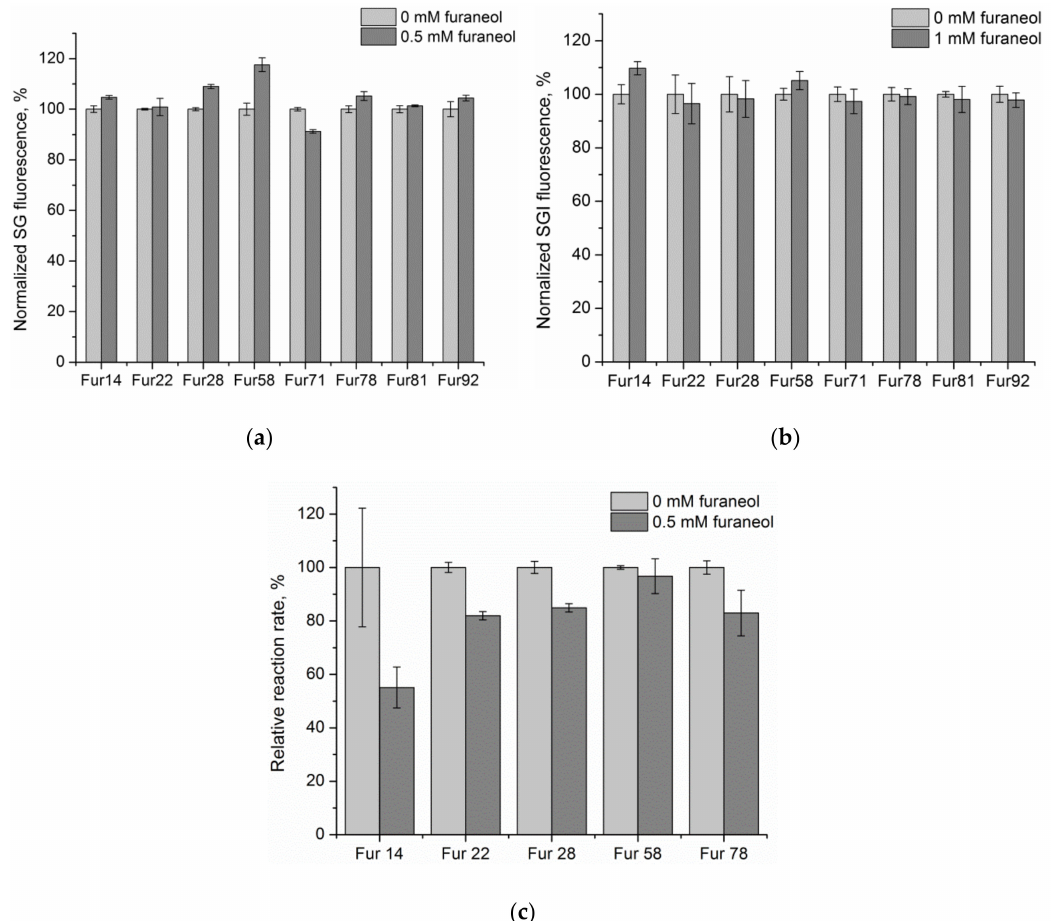
Figure 3. ( a ) Comparison of the ssDNA amount eluted by the buffer (0 mM furaneol, background elution) and by 500 µ M of furaneol. Measurements were performed in duplicates. Background elution for each aptamer was set as 100%. ( b ) Comparison of the SGI fluorescence intercalated with the aptamer candidates, in the absence (0 mM) and in the presence of 1 mM furaneol. Measurements were performed in triplicates. Fluorescence in the absence of furaneol was set as 100%. ( c ) Comparison of the initial reaction rates of the ssDNA degradation by exonuclease I, for each aptamer candidate, in the absence of furaneol and in the presence of 0.5 mM furaneol. Measurements were performed in duplicates. Reaction rate for each aptamer, in the absence of furaneol was set as 100%. Error bars for each assay were calculated as standard